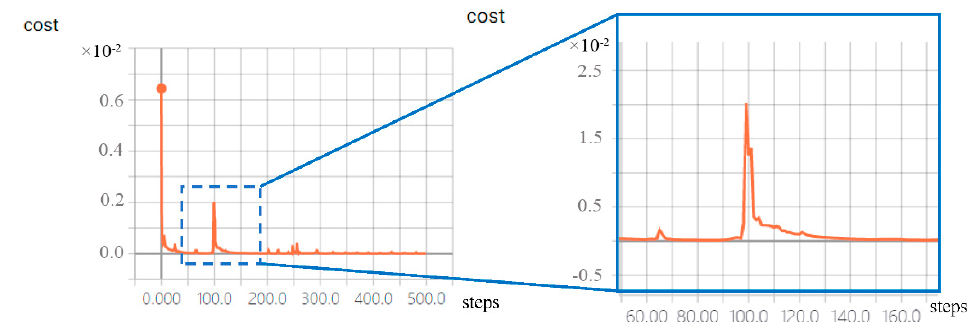
Figure 11. Oscillating situation: No. 2 training datasets make the algorithm slightly unstable, with no DA process and unsuitable Adam’s initial learning rate. With 500 training steps in total and δ = 0.01, the cost became oscillating during step 50 to 500.